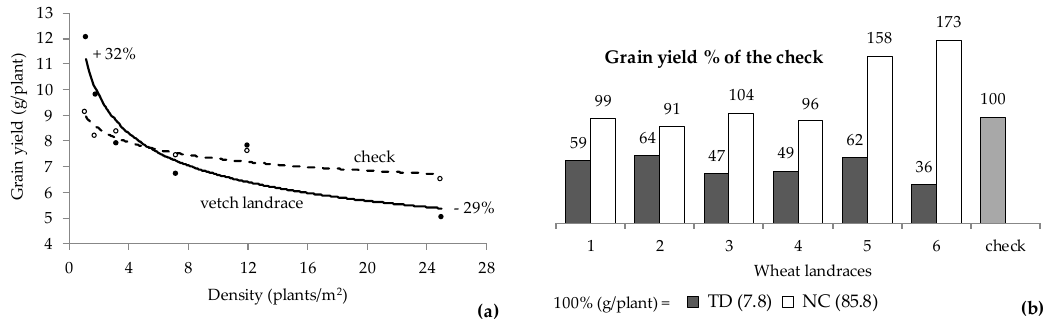
Figure 2. The performance of heterogeneous landraces against respective homogeneous checks, ( a ) across a range of densities; and ( b ) at typical density (TD) and nil -competition (NC), indicate that high yielding genotypes involved in a landrace are expressed and detectable only at NC. Adapted from ( a ) Chatzoglou and Tokatlidis [39] and ( b ) Ninou et al. [40].